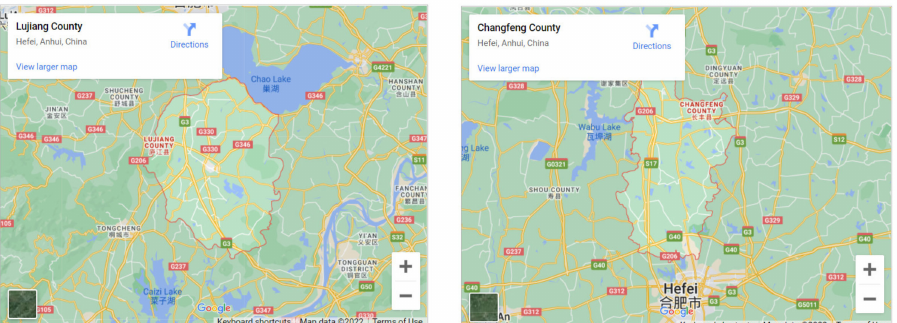
The paddy fields in Lujiang County and Changfeng County in Anhui Province are